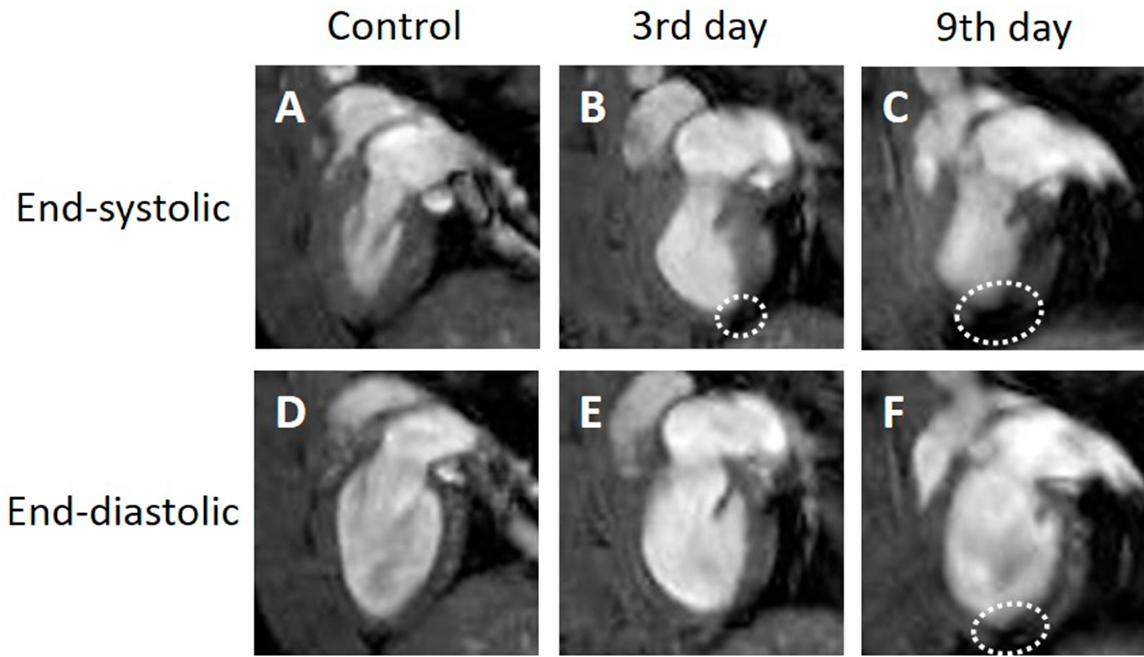
Figure 2. Representative two-chamber view cine magnetic resonance images. Control ( A , D ), 3 days after the onset of myocardial infarction ( B , E ), 9 days after the onset of myocardial infarction ( C , F ). End-systolic phase of the rat heart ( A , B , C ), end-diastolic phase of the rat heart ( D , E , F ). White dotted circles: infarcted area.